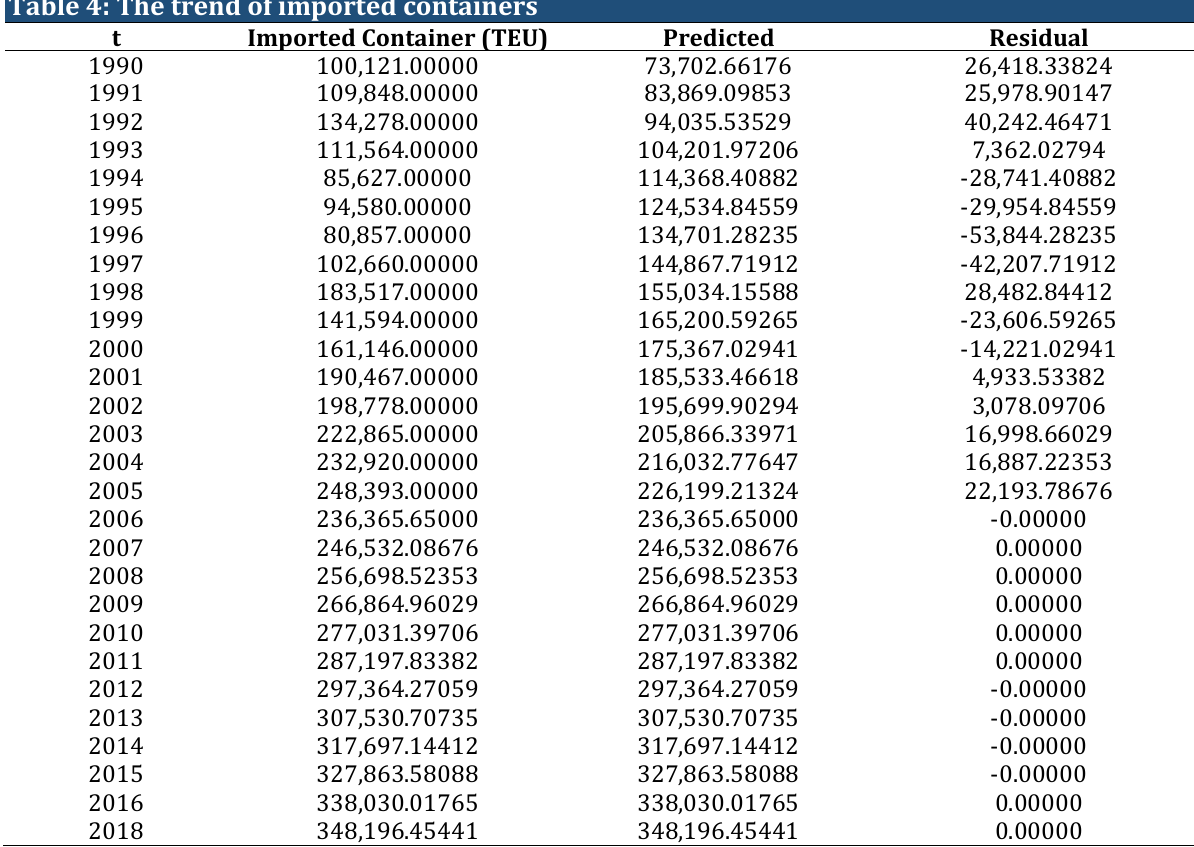
Table 4: The trend of imported